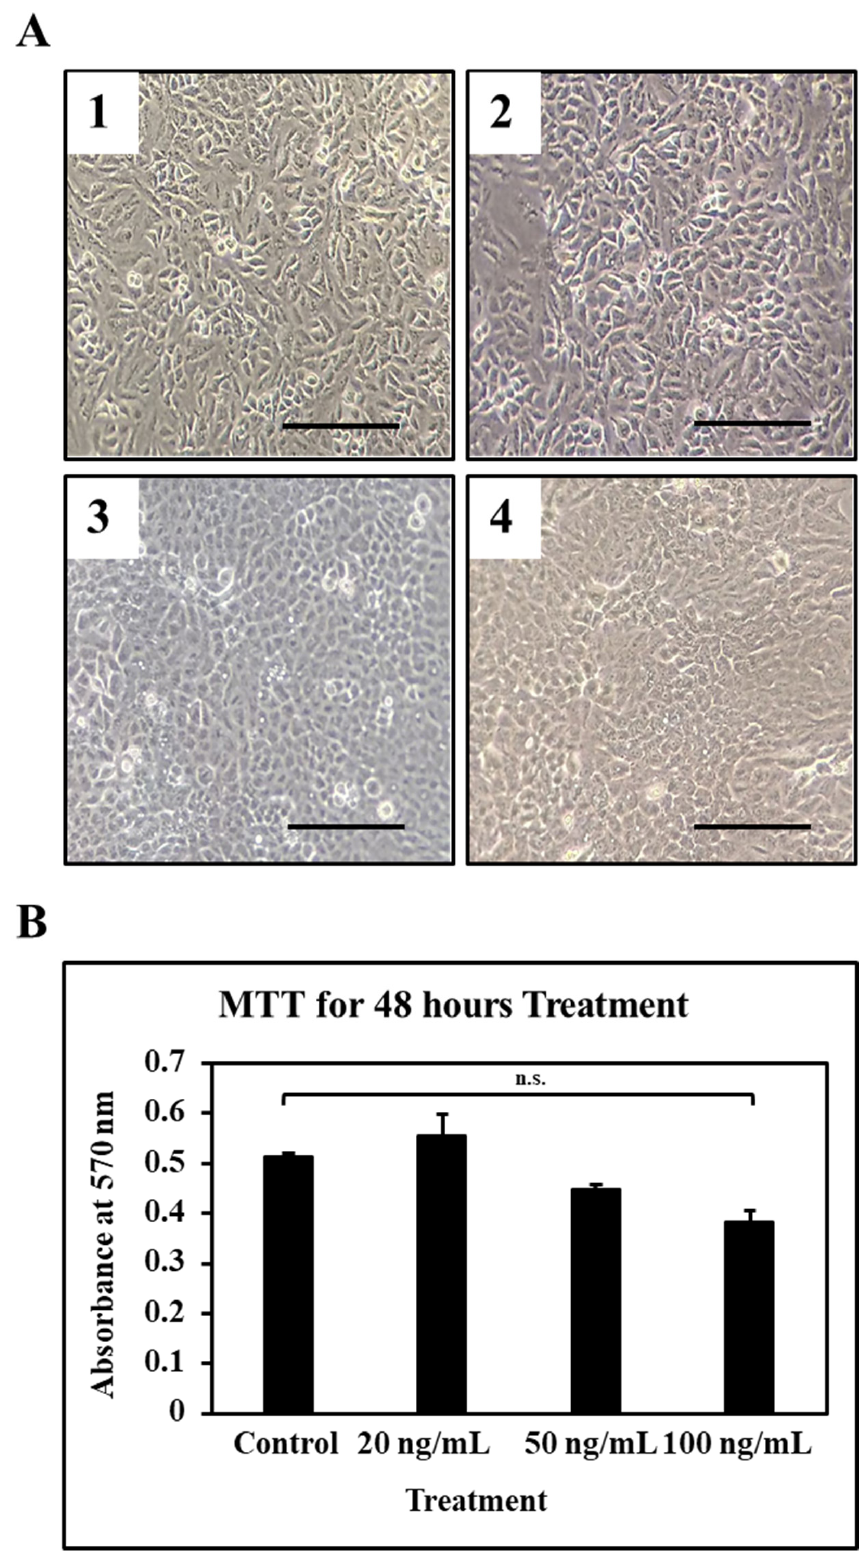
Figure 2. OSCC cells were treated with different concentrations of allicin and MTT assay was performed to check the cell viability. ( A ) Morphology of the OSCC cells after treatment with allicin: Control A1, 20 ng/mL A2, 50 ng/mL A3, 100 ng/mL A4. Scale bar = 100 µm. ( B ) MTT assay. n.s. not significant .